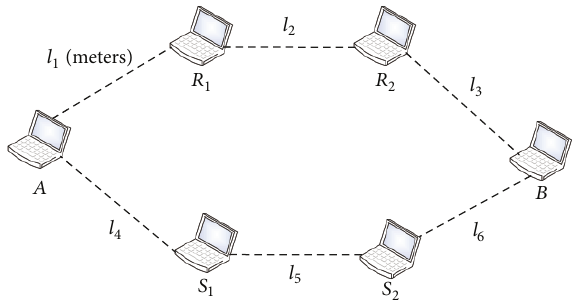
Figure 4: One common node distribution of the